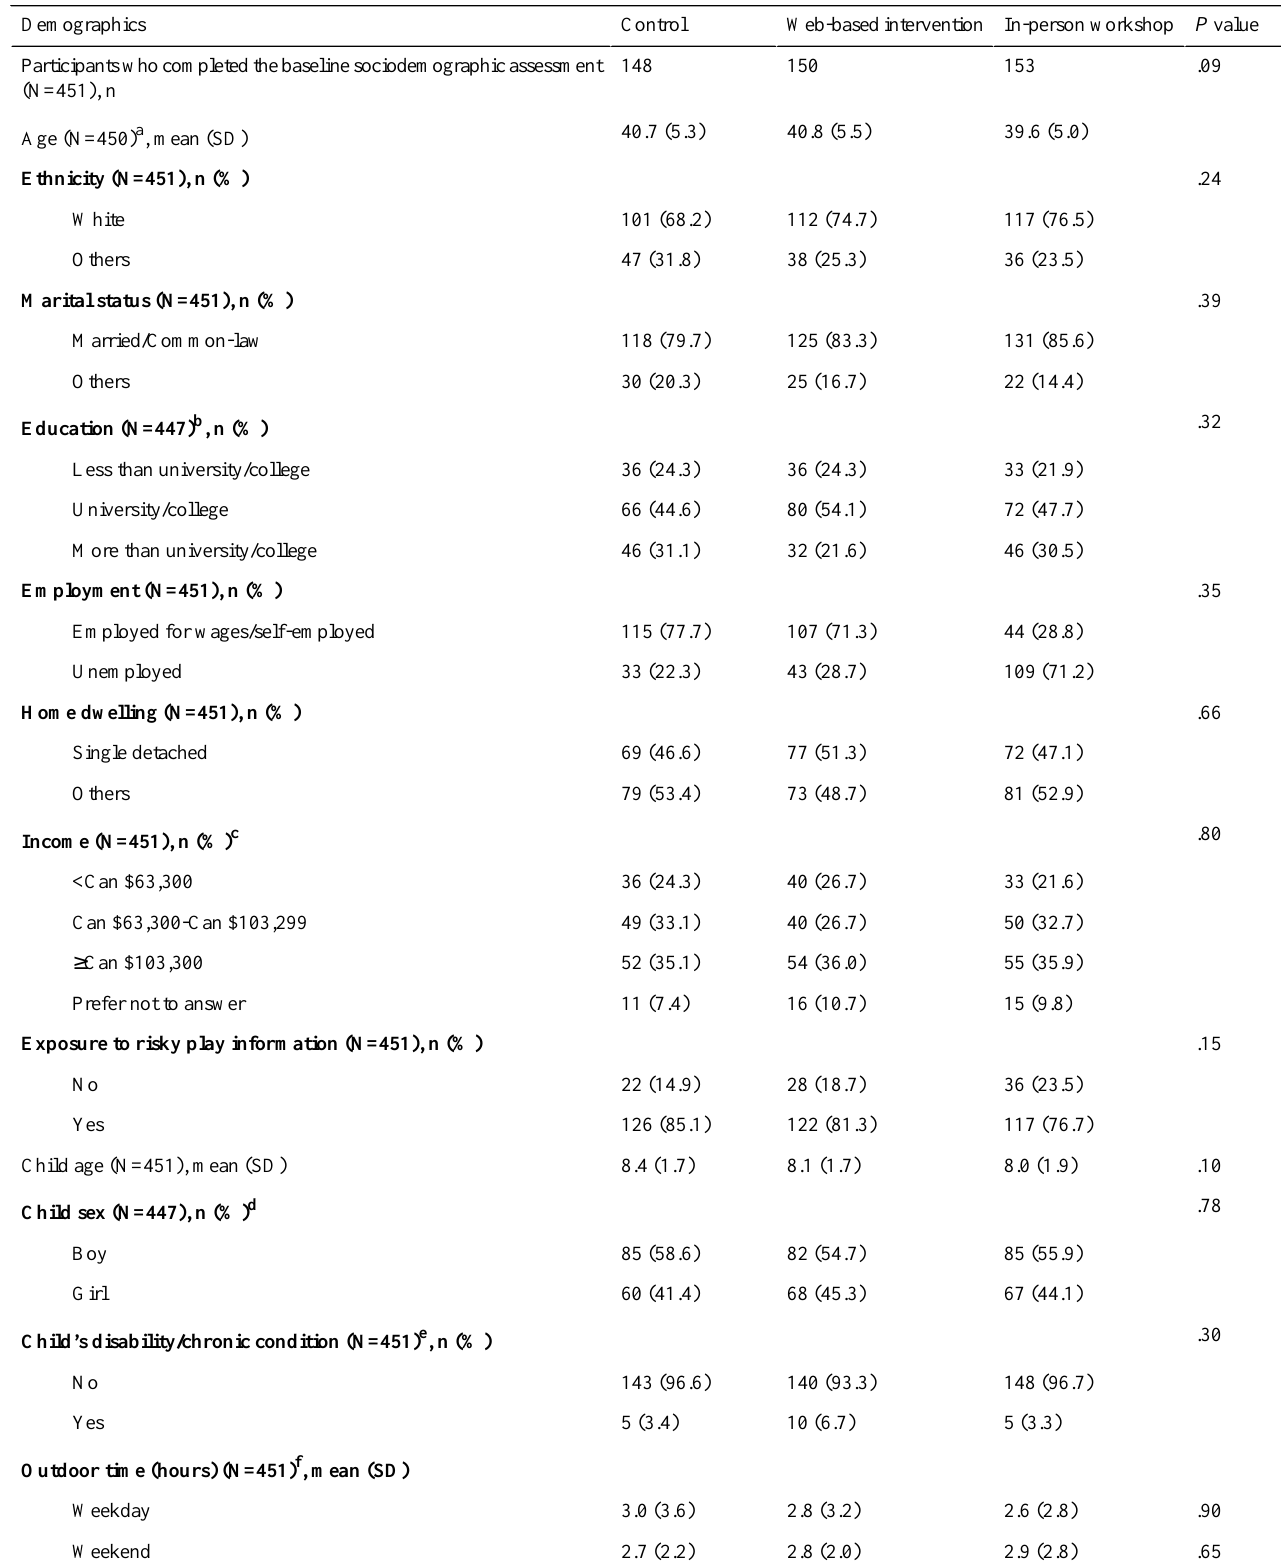
P valueIn-person workshopWeb-based interventionControlDemographics